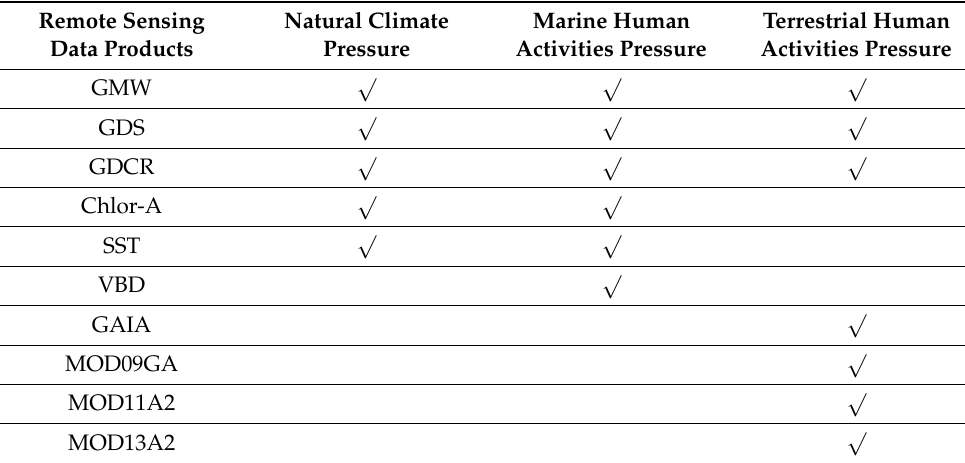
Table 2. Classification of data products based on the purpose of the